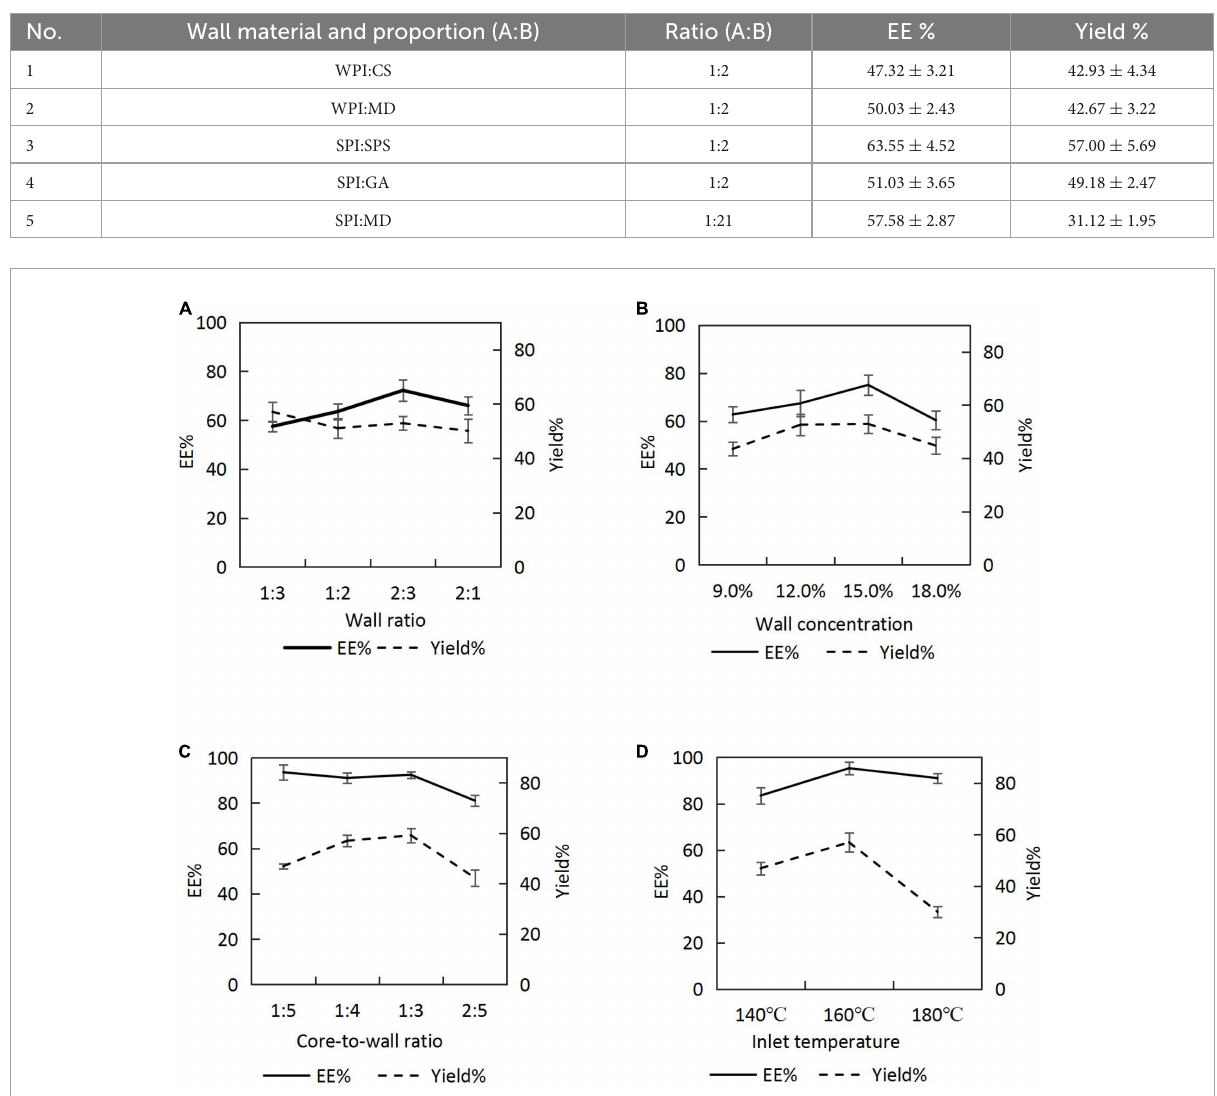
FIGURE2 Encapsulation efficiencies (EEs) and yields of microcapsules under different process conditions: (A) wall ratio; (B) wall concentration; (C) core-to-wall ratio; (D) inlet temperature.